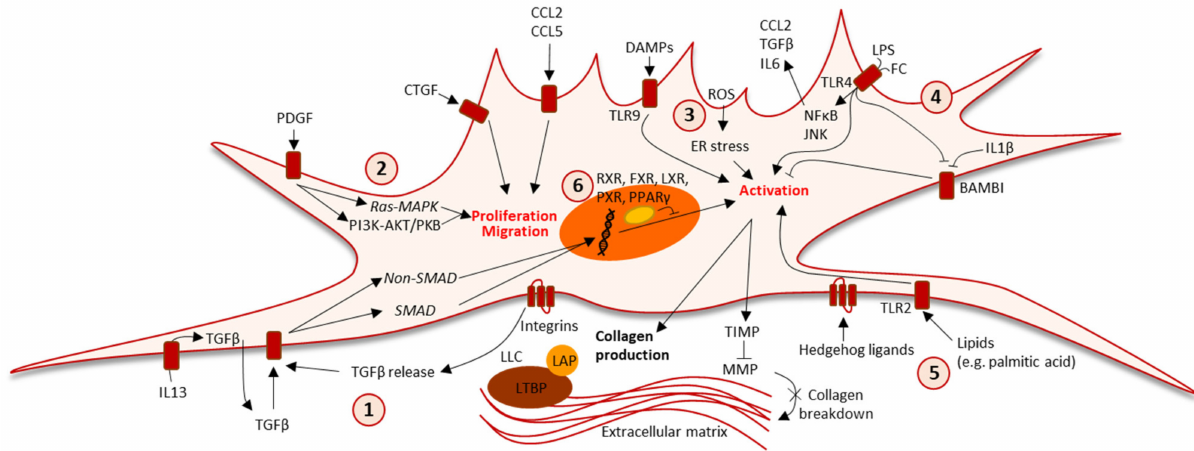
Figure 3. Molecular mechanisms of hepatic stellate cell activation. The activation of hepatic stellate cells involves multiple signaling pathways and receptor systems. 1: TGF β is one of the most potent fibrogenic factors and is released in response to insults. In HSCs, TGF β is released through IL-13-dependent induction and via integrin-mediated interactions with extracellular TGF β stored in a LLC. TGF β acts through SMAD and non-SMAD pathways to increase collagen synthesis and extracellular matrix deposition. An increased TIMP level inhibits MMP expression and collagen breakdown. 2: PDGF induces RAS-MAPK and PI3K-AKT/PKB signaling that—alongside cytokines and growth factors such as CCL2, CCL5, and CTGF—promotes HSC proliferation and migration. 3: Increased ROS induce ER stress, which (alongside DAMPs) leads to HSC activation. 4: Gut permeability may increase in NASH, and gut-derived and hepatic FC signaling through TLR4 promotes the production of inflammatory cytokines, growth factors, and HSC activation. In addition, TLR4 signaling can indirectly activate HSCs by decreasing the expression of the TGF β decoy receptor BAMBI, which is also decreased by the inflammatory cytokine IL-1 β . 5: In turn, lipotoxic lipid (e.g., palmitic acid) signaling through TLR2 and Hedgehog-derived signaling further contributes to HSC activation. 6: Nuclear receptors also play an important role in HSC activation, being inhibited by RXR, FXR, LXR, PXR, and PPAR γ (decreased in activated HSCs). Though all mechanisms of HSC activation remain to be disclosed, this figure illustrates the highly complex cellular signaling patterns involved in NASH- associated HSC activation and the subsequent production of a fibrous extracellular matrix. AKT/PKB: protein kinase B. CTGF: connective tissue growth factor. BAMBI: bone morphogenetic protein and activin membrane-bound inhibitor. CCL: chemokine C-C motif ligand. DAMP: damage-associated molecular patterns. ER: endoplasmic reticulum. FC: free cholesterol. FXR: farnesoid X receptor. HSC: hepatic stellate cell. IL: interleukin. LPS: lipopolysaccharide. LAP: latency-associated protein. LLC: large latent complex. LTBP: latent TGF- β -binding protein. LXR: liver X receptor. MAPK: mitogen-activated protein kinase. MMP: matrix metalloproteinase. NAFLD: non-alcoholic fatty liver disease. PDGF: platelet-derived growth factor. PI3K: phosphoinositide 3-kinase. PPAR γ : peroxisome proliferator-activated receptor γ . PXR: pregnane X receptor. ROS: reactive oxygen species. RXR: retinoid X receptor. TIMP: tissue inhibitor of matrix metalloproteinase. TGF β : tissue growth factor β . TLR: toll-like receptor. SMAD: mothers against decapentaplegic homolog. Arrow heads indicate activation, and transversal lines indicate